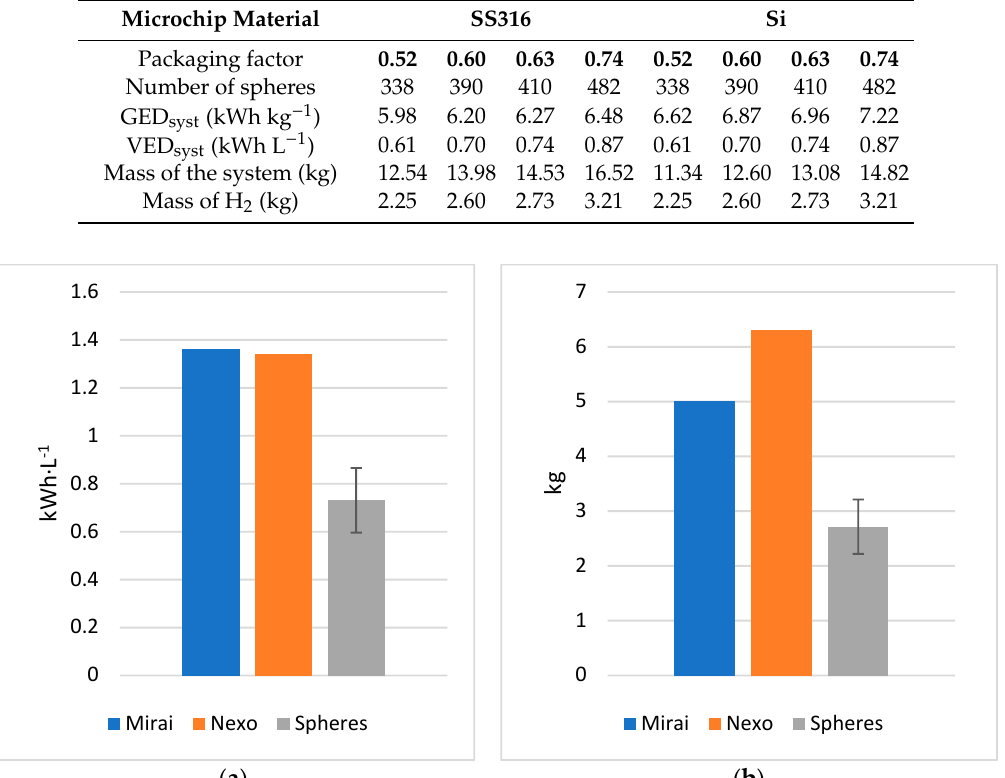
Figure 12. Comparison between the system under study and the storage systems of Toyota Mirai and Hyundai Nexo, regarding the ( a ) VED and ( b ) the mass of stored hydrogen.